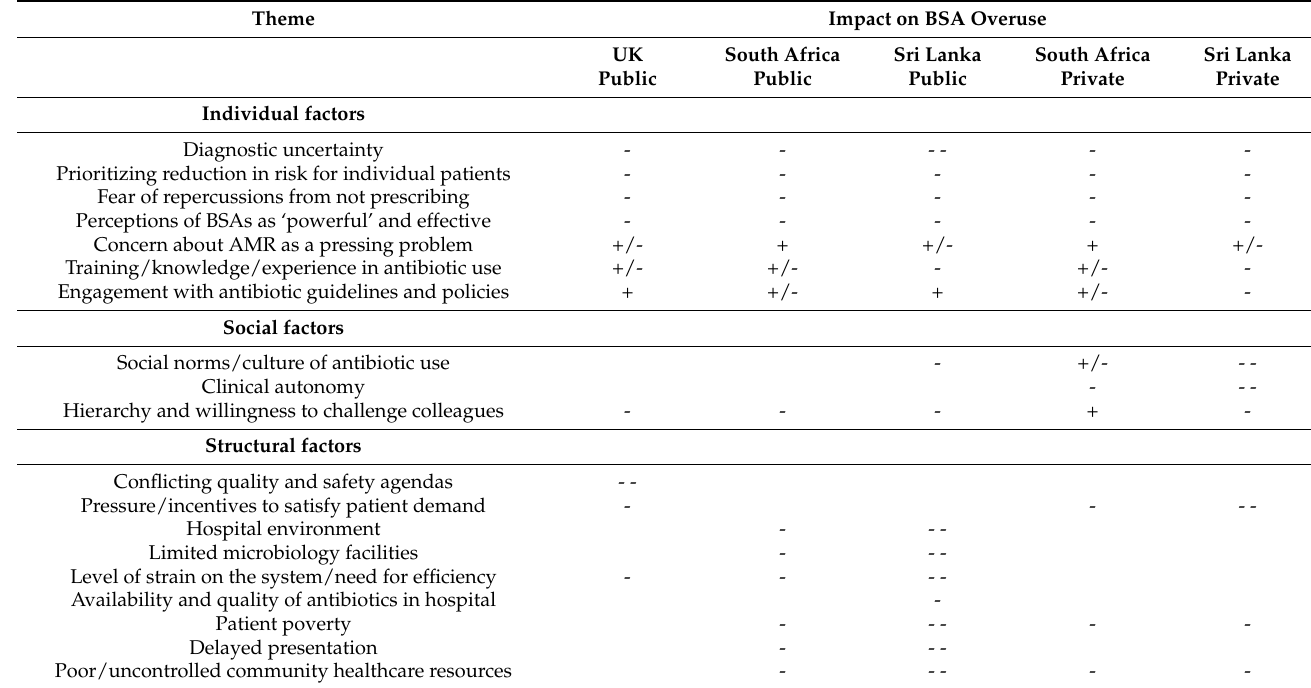
Table 2. Influencing factors mapped by